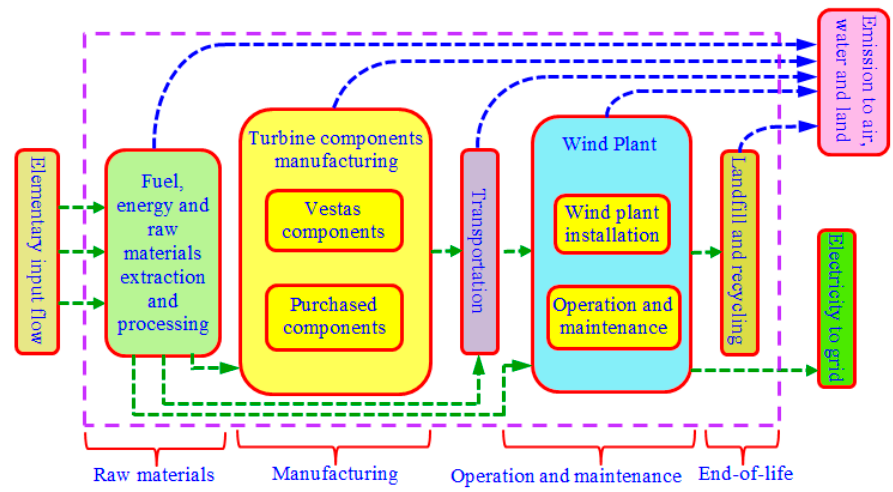
Figure 3. System Figure 3. System boundaries.